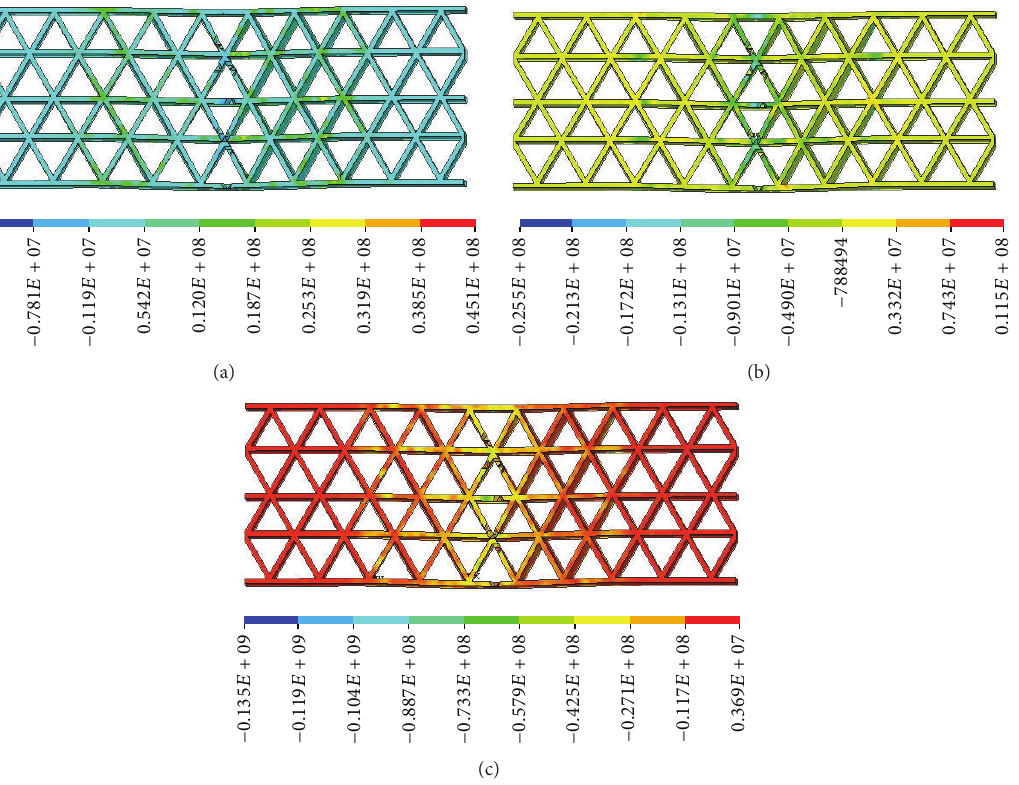
Figure 7: Triangular core stress distribution: (a) 1st principal stress; (b) 2nd principal stress; (c) 3rd principal